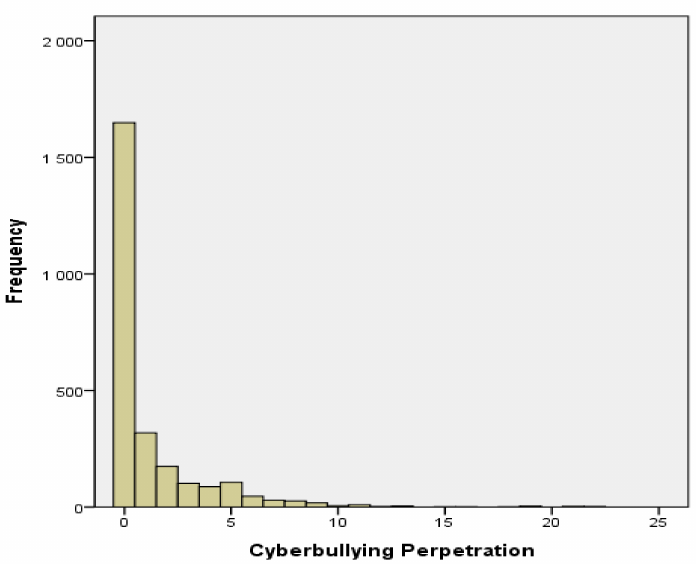
Figure 1. Frequency of cyberbullying perpetration among South Korean middle school students.